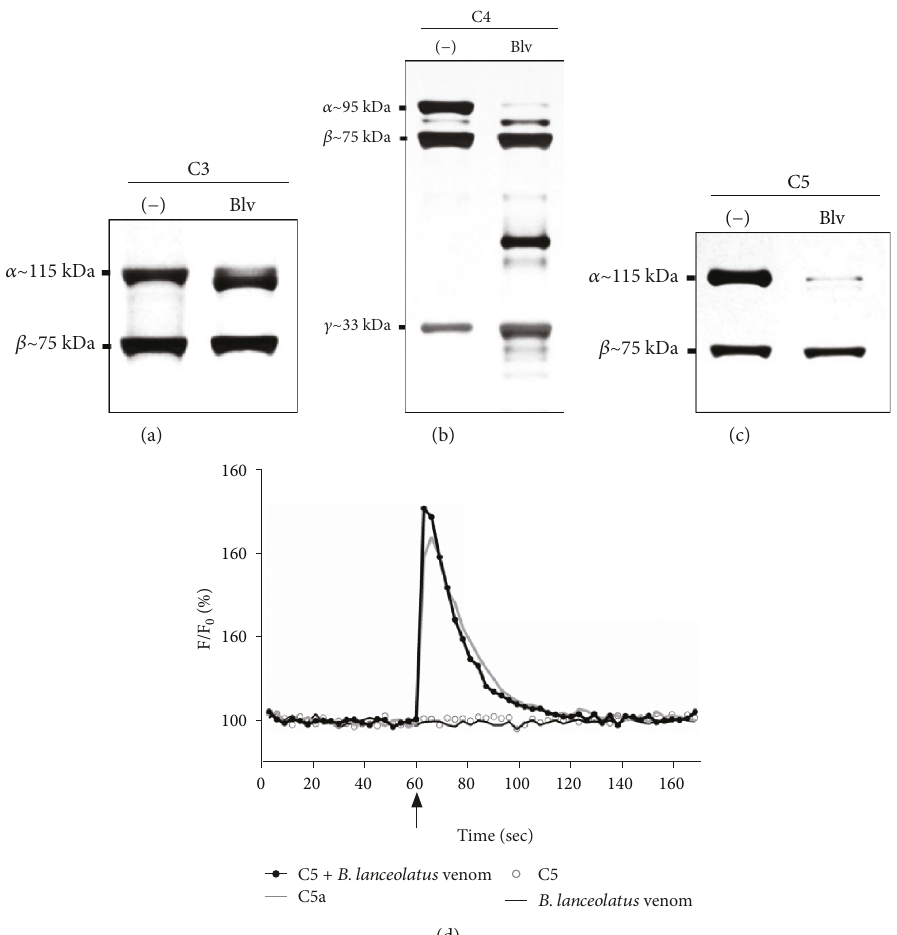
Figure 3: Cleavage of puri fi ed C3, C4, and C5 by B. lanceolatus venom. Samples (2 μ g) of puri fi ed Complement components C3 (a), C4 (b), and C5 (c) were incubated in PBS with B. lanceolatus venom (2 μ g) for 30min at 37 ° C. The cleavage was visualized by electrophoretic separation (10% acrylamide SDS-PAGE) under reducing conditions, followed by silver staining. (d) The functional activity of the venom-treated C5 fragments was assessed via measuring calcium in fl ux in Fluo-4-AM-labelled leukocytes (5 × 10 6 cells/mL). Puri fi ed C5a (2.4ng/mL) and samples of C5 or venom incubated with saline were used as positive and negative controls, respectively. Cells were allowed to equilibrate for 60sec before stimulation